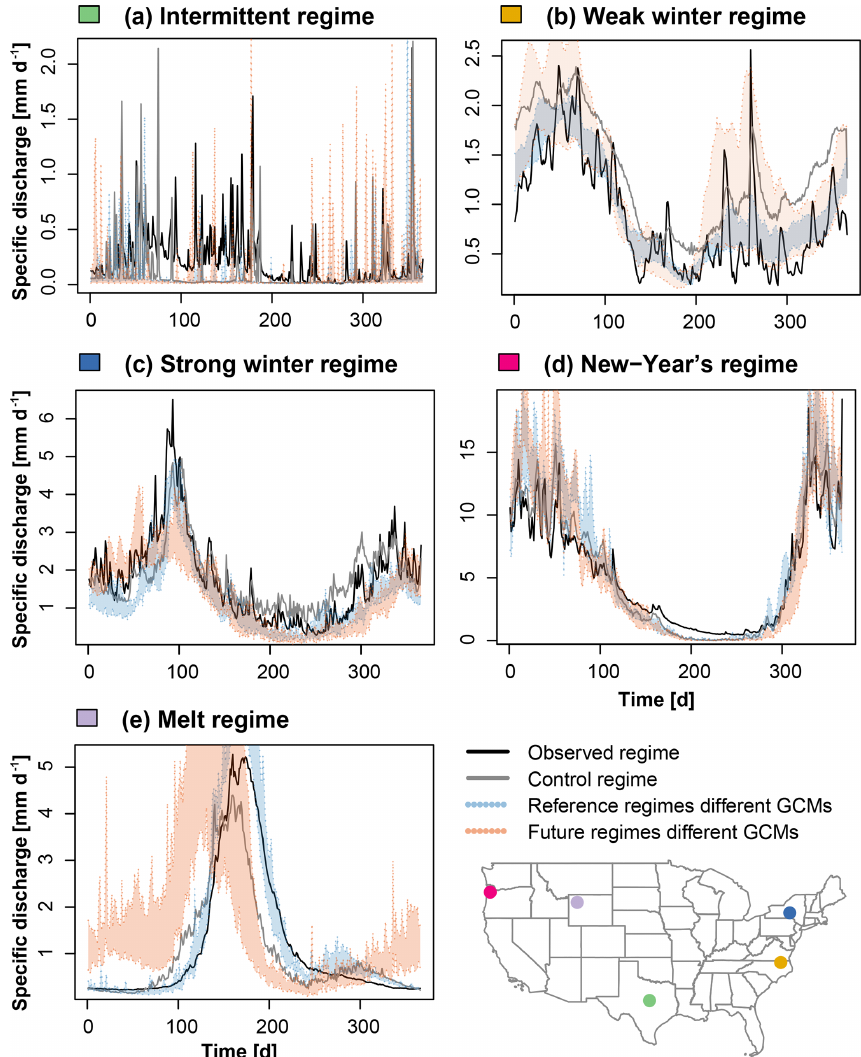
Figure 5. Comparison of observed (black) and simulated control regimes (observed meteorology; grey) with simulated reference (1981– 2008; blue) and future regimes (2070–2100; red) derived from the five GCMs for the five example catchments, one per regime type: (a) intermittent regime: Cowhouse Creek at Pidcoke, TX (USGS 08101000); (b) weak winter regime: Potecasi Creek near Union, NC (USGS, 02053200); (c) strong winter regime: Otselic River at Cincinnatus, NY (USGS 01510000); (d) New Year’s regime: Tucca Creek near Blaine, OR (USGS 14303200); and (e) melt regime: South Fork Shoshone River near Valley, WY (USGS